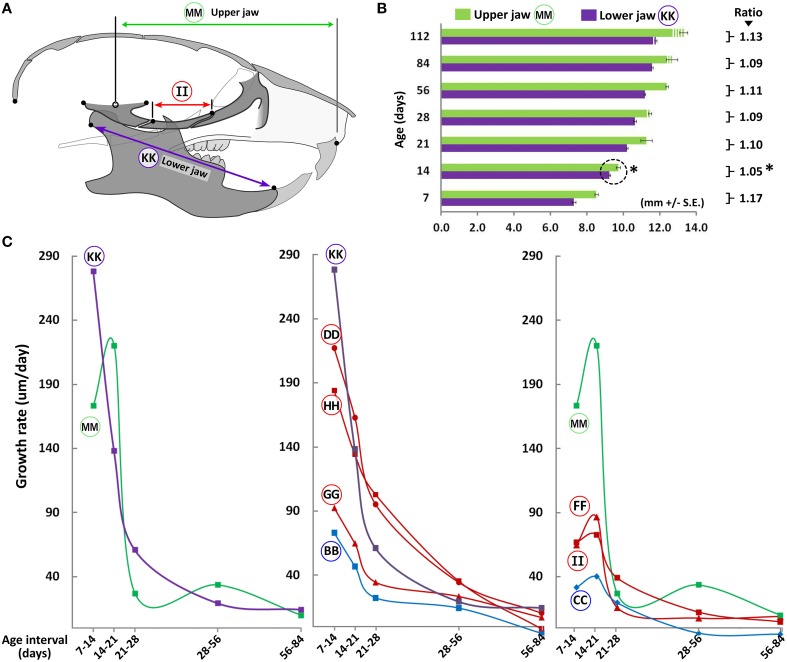
Coordinated growth of the upper and lower jaws through ontogeny. (A) Schematic of the lateral view of the mouse skull depicting landmarks used to obtain measurements of the upper and lower jaws (mandible). (B) Bar graph showing upper (green) and lower (purple) jaw growth with increasing postnatal age. Numbers next to square parenthesis indicate the ratio of the upper/lower jaw at each age, which is at its minimum at P14 (asterisk). (C) Growth velocity curves of individual bones or facial regions (μm/day, y-axis) with age interval (x-axis). Label adjacent to each curve is depicted in the schematic shown here and in Figure 3A (see Table 1 for description).